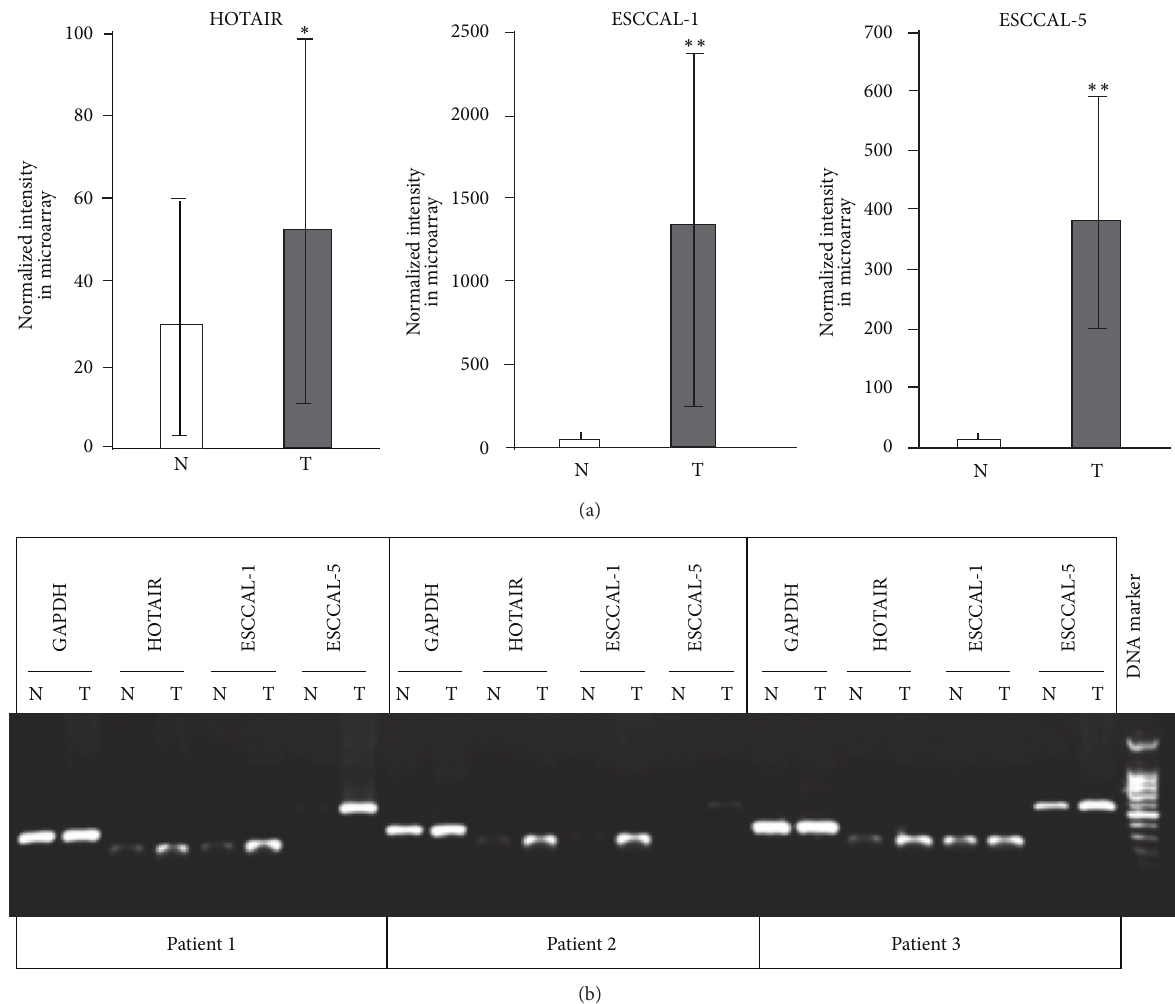
Figure 2: Long noncoding RNAs (lncRNAs) expression in esophageal squamous cell carcinoma (ESCC). (a) Three differentially expressed lncRNAs, HOTAIR, ESCCAL-1, and ESCCAL-5, from microarray detection. The average intensity of expression in normal tissues (N) and tumors (T) is plotted with their standard deviations. (b) Validation of HOTAIR, ESCCAL-1, and ESCCAL-5 with independent patient samples by PCR analysis. The amplicons were separated with 2% agarose gel. GAPDH was used as an internal control. Significance is ∗ 𝑃 < 0.05 , ∗∗ 𝑃 < 0.01 .